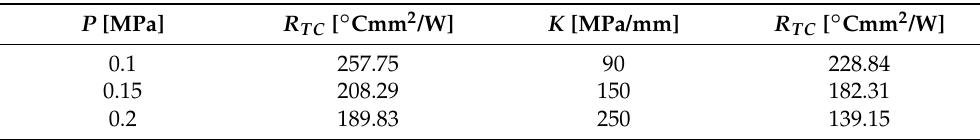
Table 5. Median thermal contact resistance R TC comparison for the uniform clamping pressure P and Winkler elastic supports stiffness K .